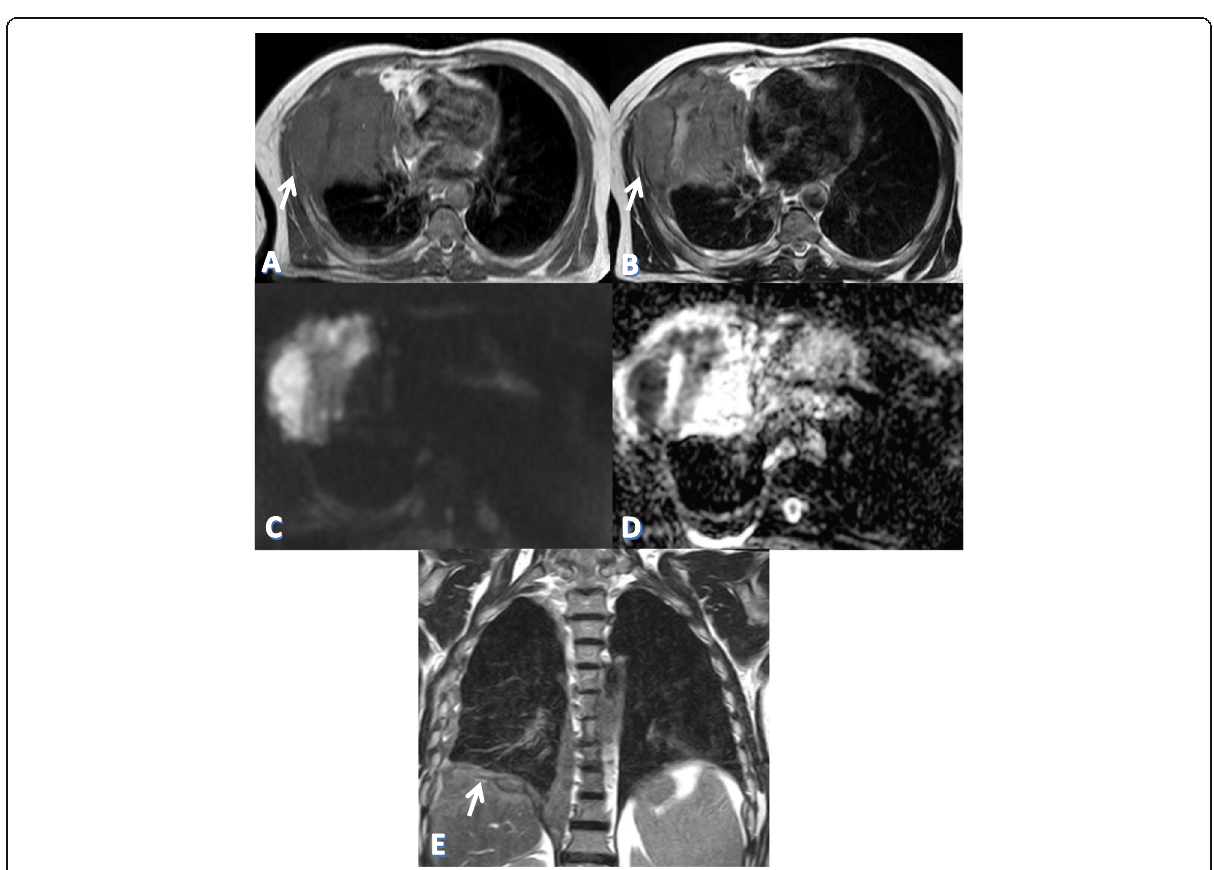
Fig. 4 a Axial T1 WI, b axial T2 WI, and e coronal T2 WI showing right circumferential nodular pleural thickening mounting to mass formation eliciting heterogeneous predominately low T1 and high T2 signal intensities with evidence of chest wall and diaphragmatic invasion (white arrows). c DWI and d ADC map showing restricted diffusion, with the bright signal on the DWI corresponding to dark signal on the ADC map (ADC mean = 0.45 × 10 − 3 mm 2 /s). CT-guided biopsy revealed malignant pleural